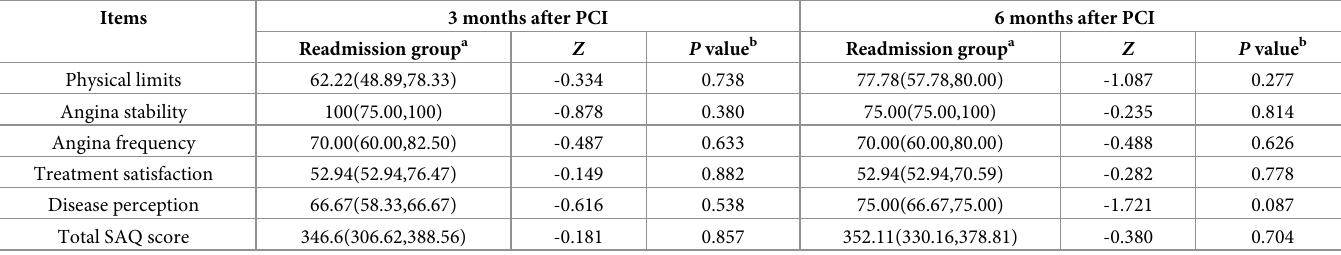
Table 6. Relationship between readmission and quality of life at 3 and 6 months after PCI. Items 3 months after